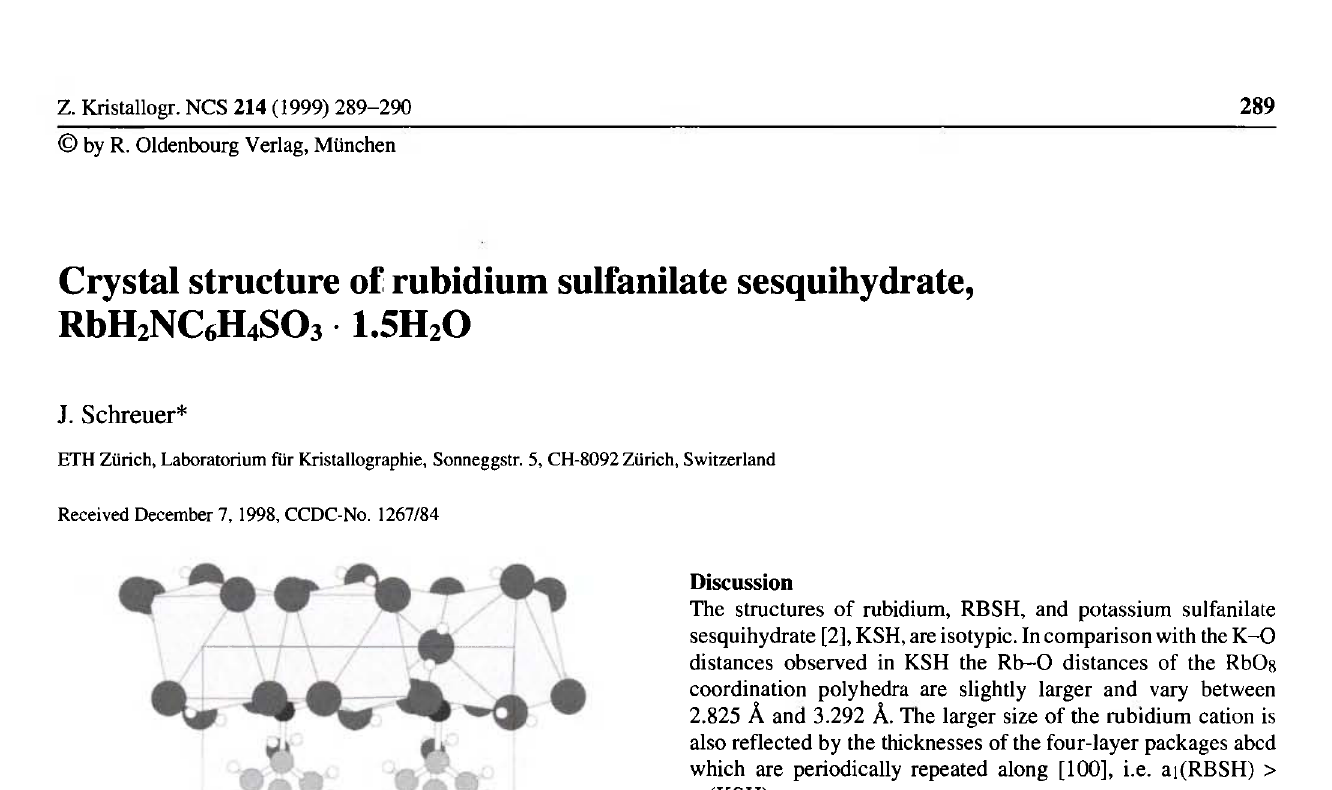
Table 1. Data collection and handling.